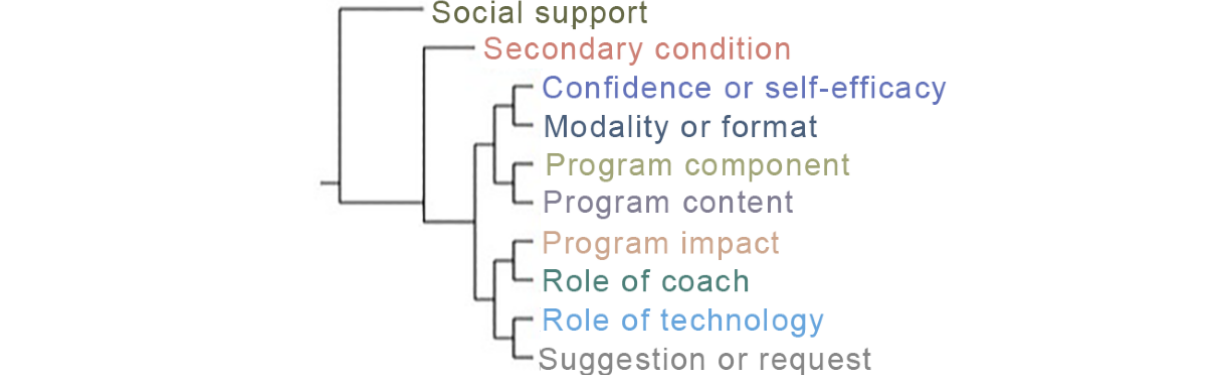
Figure 2. Tree Map of codes as generated by NVivo software. Codes that are close together are those with high Jaccard